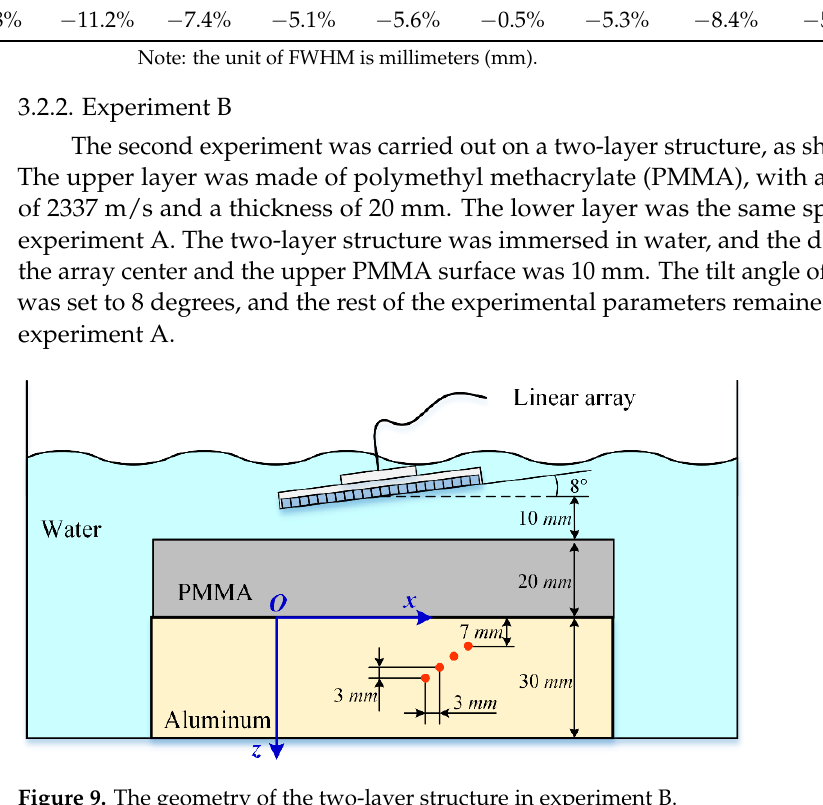
Figure 9. The geometry of the two-layer structure in experiment B.